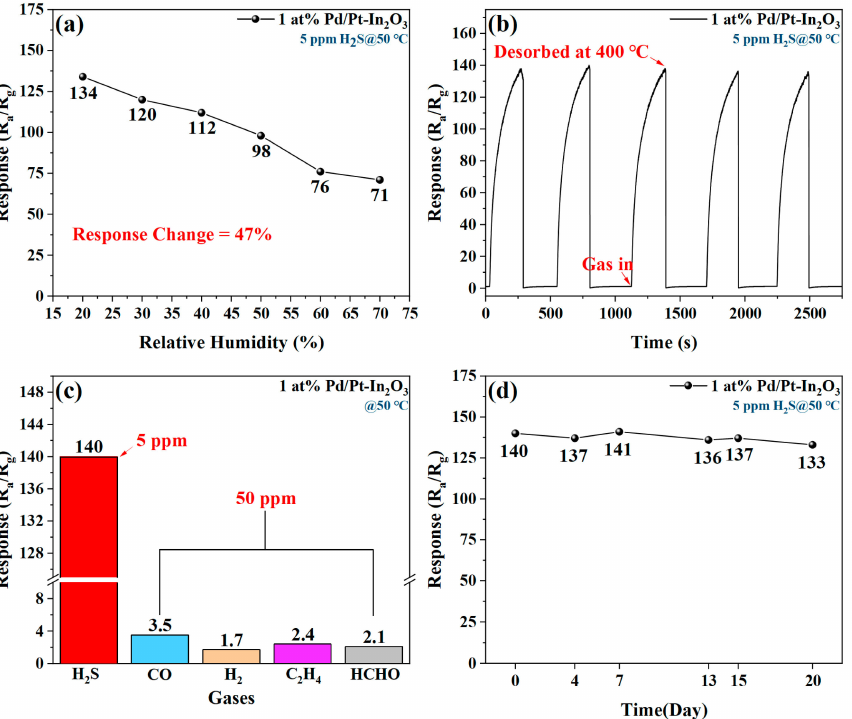
Figure 8. ( a ) Effect of humidity on H 2 S sensing of 1 at% Pd/Pt-In 2 O 3 . ( b ) Five-time repeatability of 1 at% Pd/Pt-In 2 O 3 to 5 ppm H 2 S at 50 ◦ C. ( c ) Response of 1 at% Pd/Pt-In 2 O 3 to various gases (CO, H 2 , C 2 H 4 , and HCHO). ( d ) Long-term stability of 1 at% Pd/Pt-In 2 O 3 . Table 1. The comparison in H 2 S sensing performance of In 2 O 3 -based sensors between the reported literatures and our